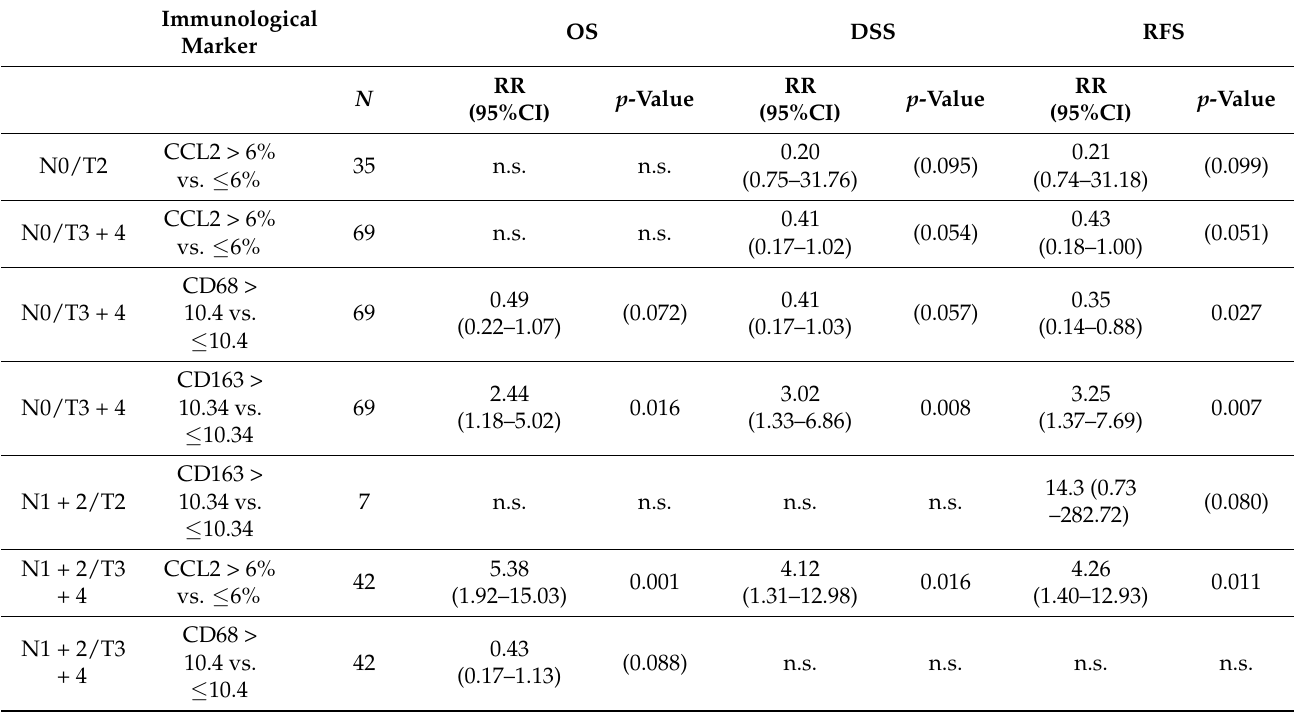
Table 5. Multivariate Cox’s regression analysis: Association between immunological markers and prognosis stratified by nodal stage and tumor stage (adjusted for chemotherapy and the immune markers CCL2, CD68, and CD163).